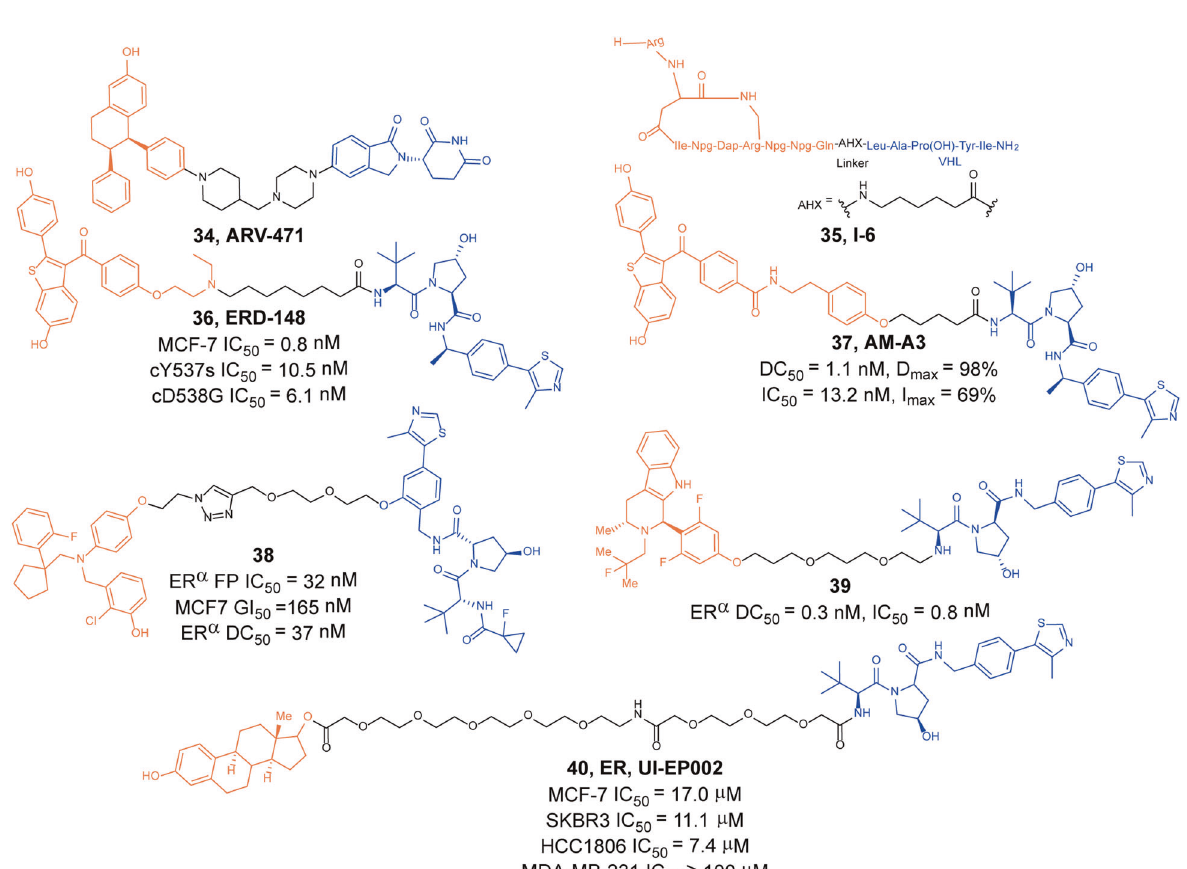
Fig. 9 The representative PROTACs targeting ER